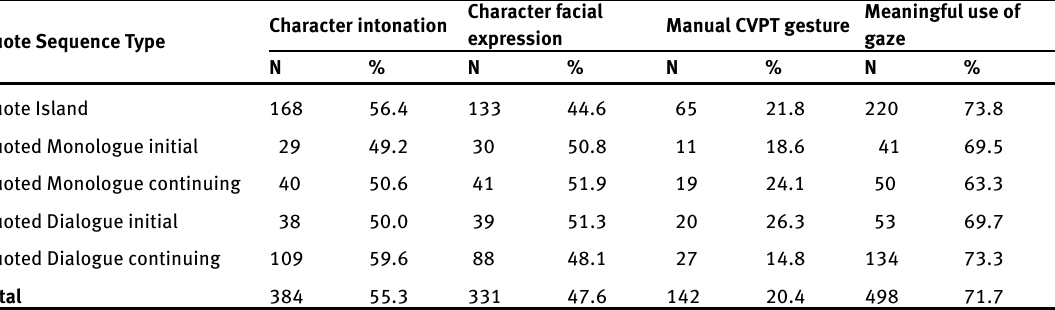
Table 4: Multimodal articulator use in the three types of quote sequences (number and proportions of quotes coded “active”)